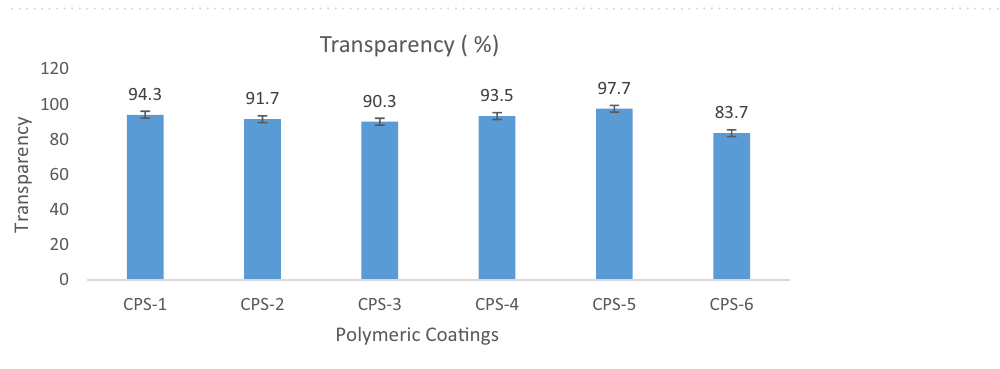
Figure 13. Graphical representation of coatings